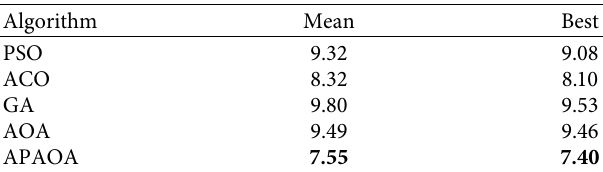
Figure 9: Path planning diagram (a) and convergence curve (b) of environment Table 9: Comparison of the APAOA with the GA, PSO, ACO, and AOA in environment 1.